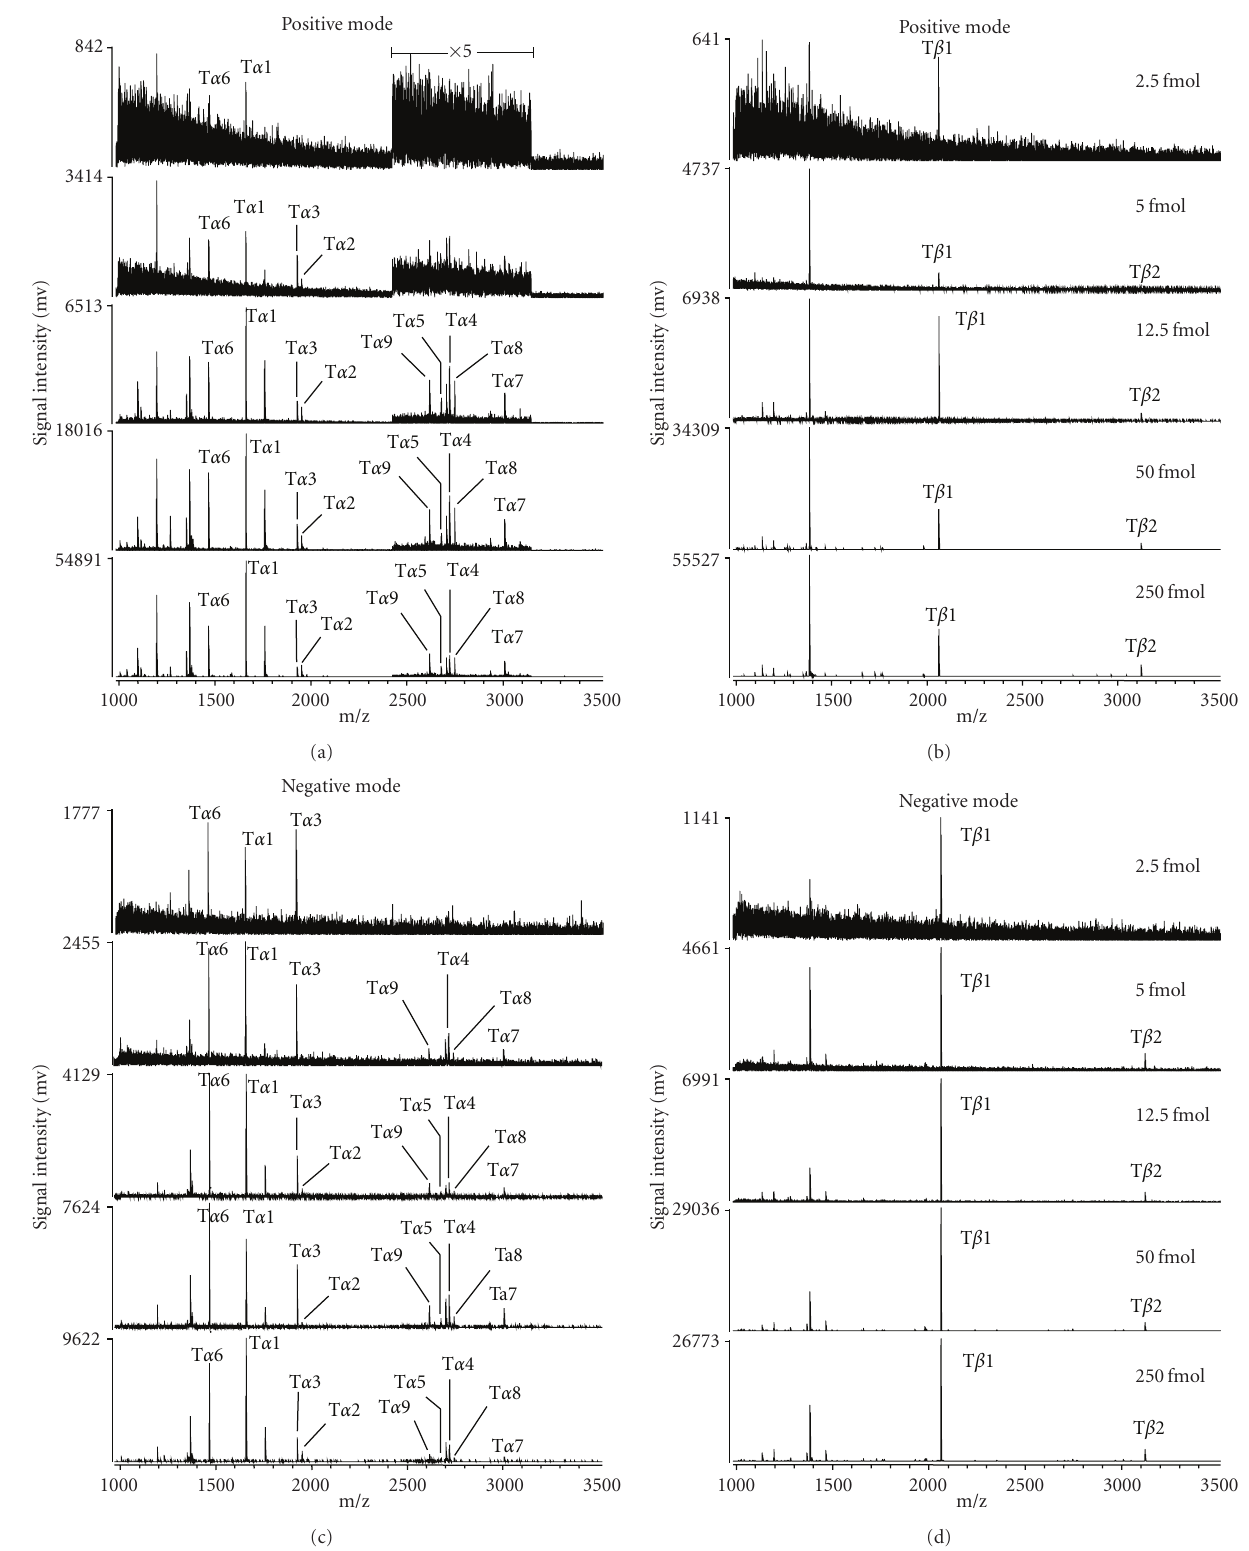
Figure 3: The MALDI mass spectra of the tryptic digest of (a) and (c) α -casein and (b) and (d) β -casein measured in positive (upper) and negative (lower) ion modes with the DHAP/DAHC matrix. The amount of the tryptic peptides mixture ranged from 5fmol to 250 fmol on target. The signal intensity is magnified 5-fold in the m/z range from 2400 to 3150 in section